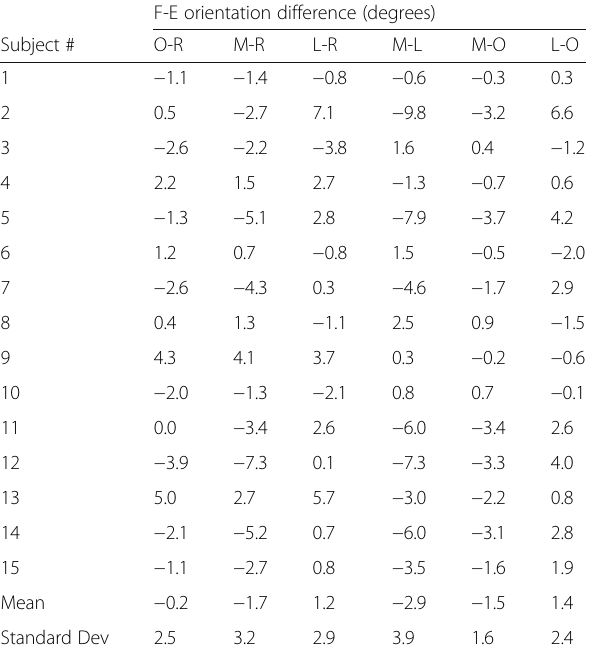
Table 4 Difference in F-E orientation between each pair of calculated planes for 15 patients